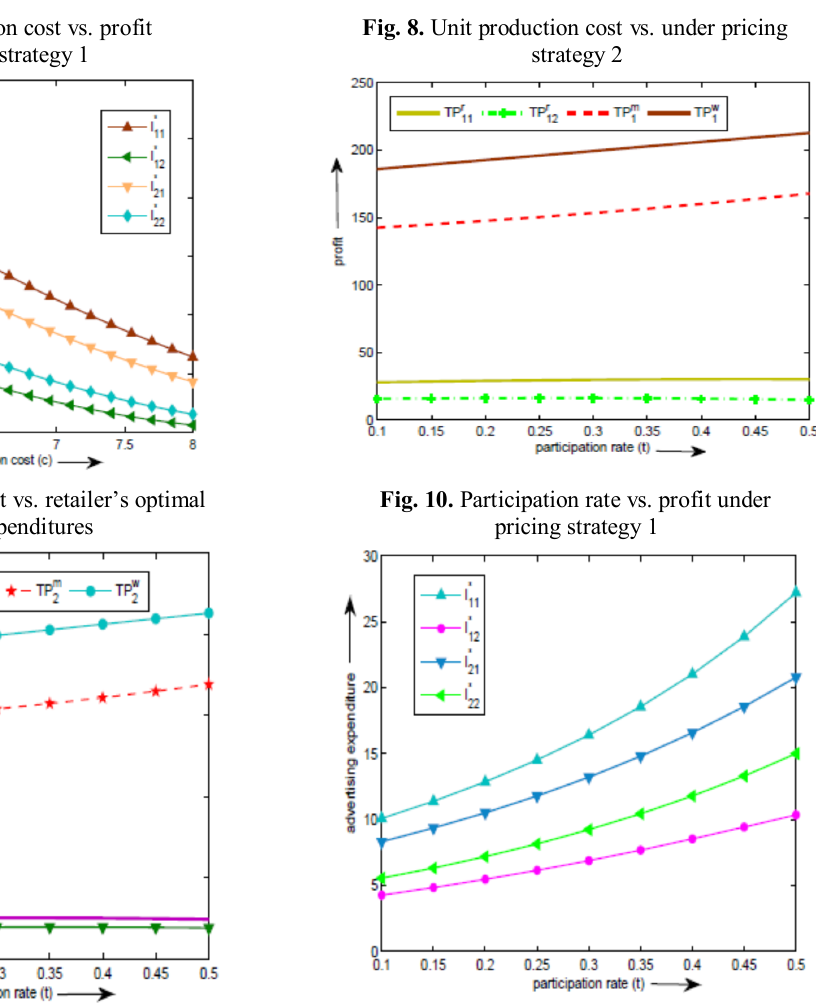
Fig. 11. Participation rate vs. profit under pricing strategy 2